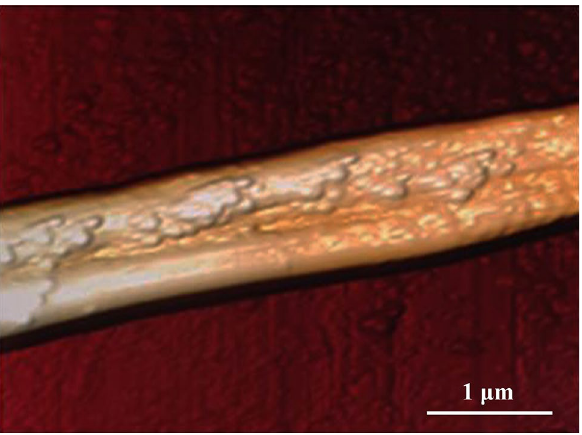
Figure 15. AFM diagram of patterned